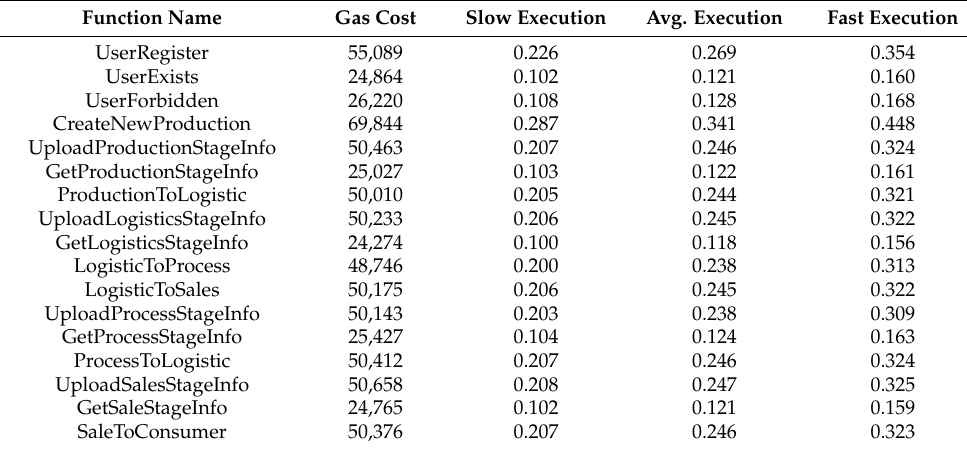
Table 6. Gas cost of Ethereum functions in USD.